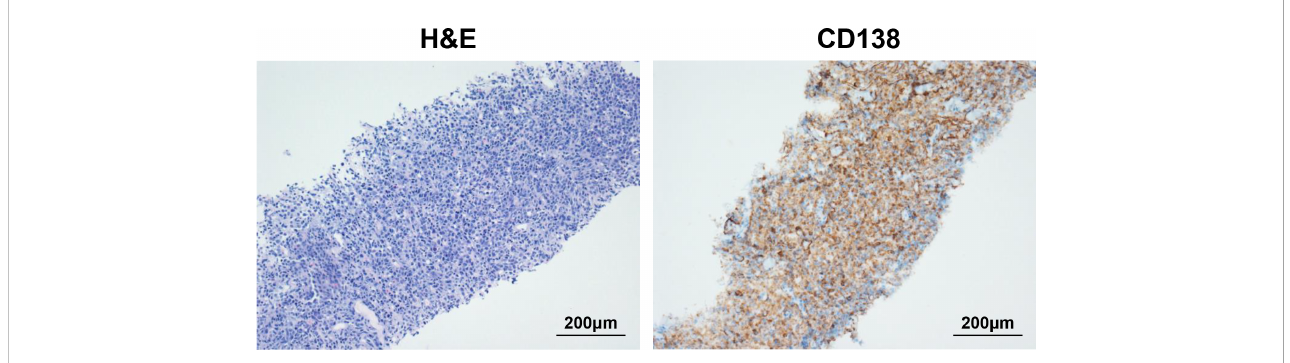
FIGURE 1 Biopsy of neck mass showing extramedullary disease (EMD). On the left is hematoxylin and eosin (H&E) staining of neck mass (original magni fi cation 200×), and on the right is immunohistochemical (IHC) staining for CD138 (original magni fi cation